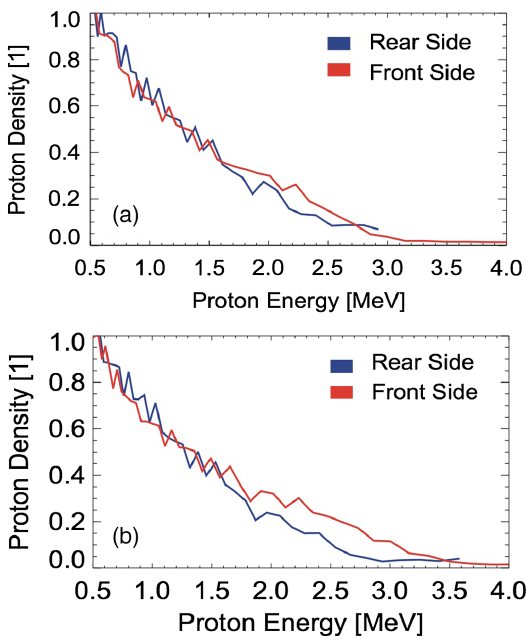
FIG. 4. Measured proton spectra corresponding to the deflecto- grams of Fig. 3(c) [spectrum (a)] and Fig. 3(a) [spectrum